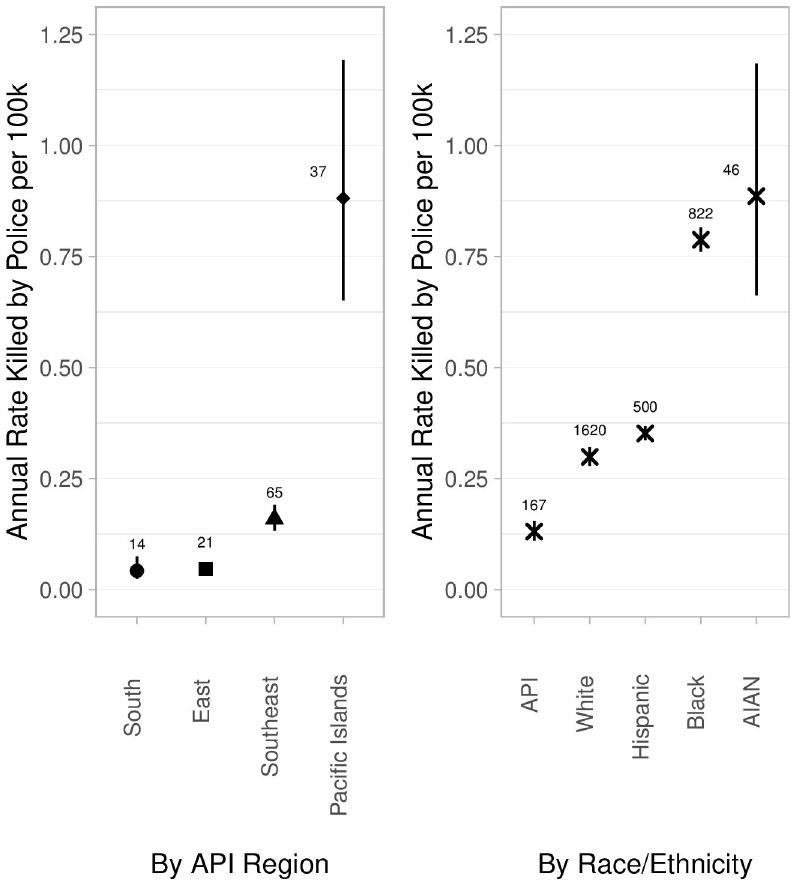
Fig 1. Estimated annual rates of fatal police violence by AAPI regional background and racial/ethnic group, 2013– 2019. Note: Vertical bars represent 95% confidence intervals. Numbers hovering above point estimates represent the number of decedents informing the estimation of each rate, calculated using a single Poisson model. Total numerator N = 137 deaths; 30/167 additional API decedents were missing regional background data. Note that there were 24 Pacific Islander and 1 Southeast Asian decedents included in Fig 1 for whom we were not able to identify national/ ethnic background and are thus not represented in Fig 2. Denominators by race/ethnicity (the right panel) are from the US Census; racial/ethnic groups are treated as mutually exclusive (i.e., the “White” group represents non-Hispanic White people, etc.).